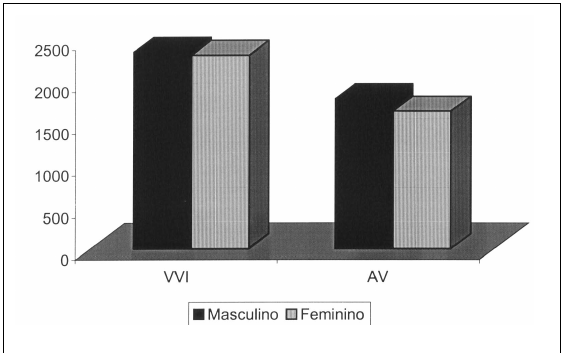
Fig. 5 - Modos de estimulação utilizados nos implantes iniciais, agru- pados segundo o sexo dos